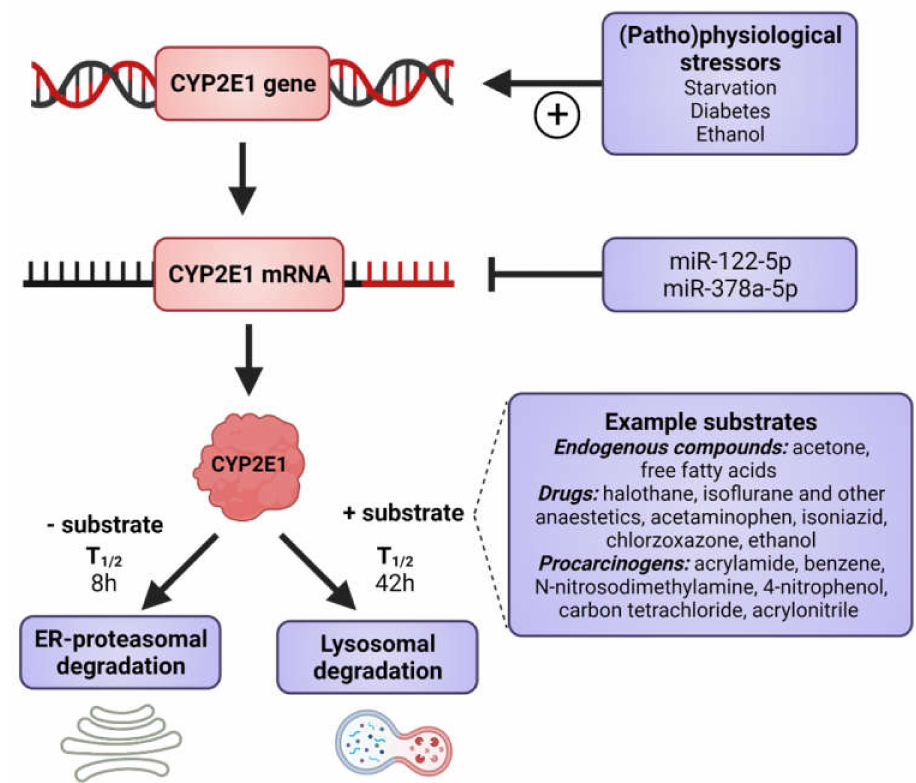
Figure 1. Factors that induce CYP2E1 expressions. CYP2E1 can be induced by multiple mechanisms in transcriptional, post-transcriptional, translational, and post-translational levels. Some physiologi- cal and pathophysiological conditions, such as starvation and uncontrolled diabetes, increase CYP2E1 on the transcriptional level. Many hormones and cytokines regulate CYP2E1 on the mRNA and protein expression levels. Enzyme substrates stabilize the enzyme, preventing degradation by the ER proteasome and the enzyme degradation instead takes place via the autophagosome-lysosomal pathway. Figure made using